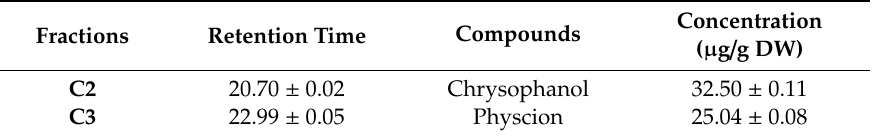
Table 3. Quantity of pure compounds from R. crispus